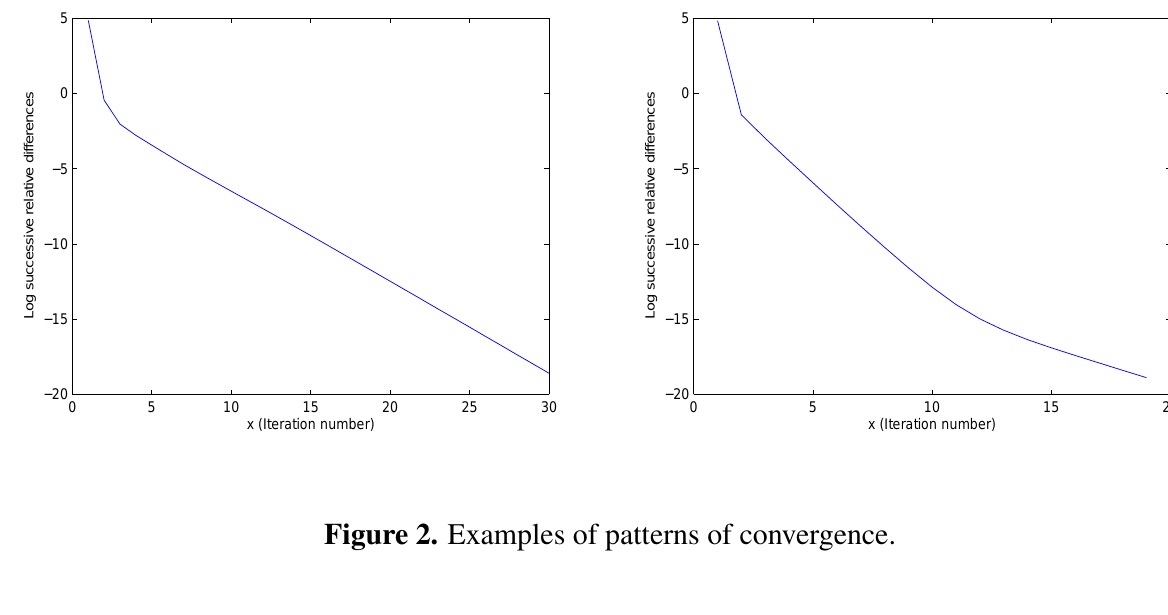
Figure 1. Examples of patterns of convergence.